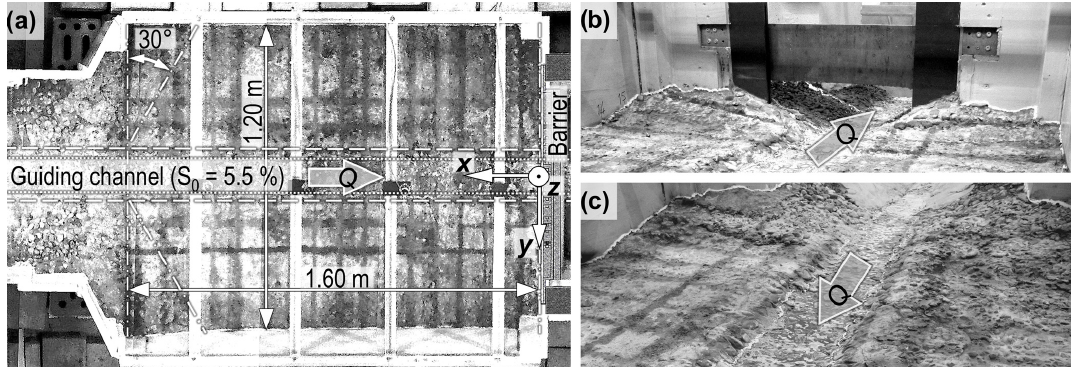
Figure 4. Details of the observation reach consisting of the deposition area (reservoir) with guiding channel. The marked grid lines on the bottom were used for qualitative purposes and had an interspace of approximately 0.1m: (a) top view with an indication of the reservoir length (1.60m), width (1.20m), opening angle (30 ◦ ) and longitudinal slope (5.5%), as well as the model coordinate system ( x,y,z axis) used for the evaluation of sediment deposits; (b) location of barriers, view in the downstream direction; and (c) deposition area (reservoir), view in the upstream